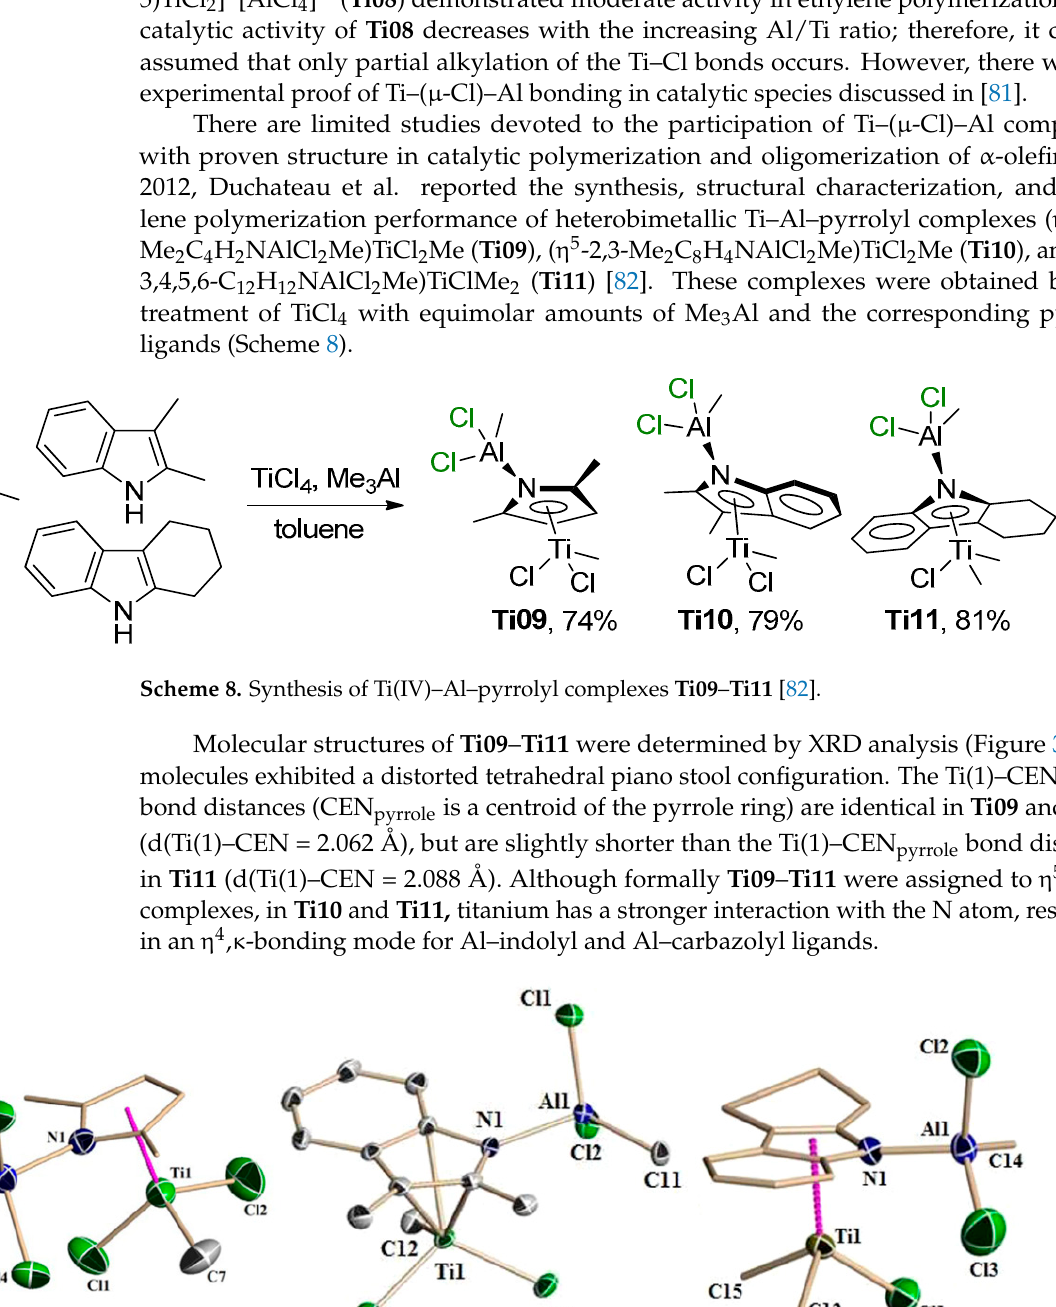
Figure 3. Molecular structures of Ti(IV)–Al–pyrrolyl complexes: ( a ) Ti09 ; ( b ) Ti10 ; ( c ) Ti11 . Re- printed with permission from [82]. Copyright (2012) American Chemical Society.